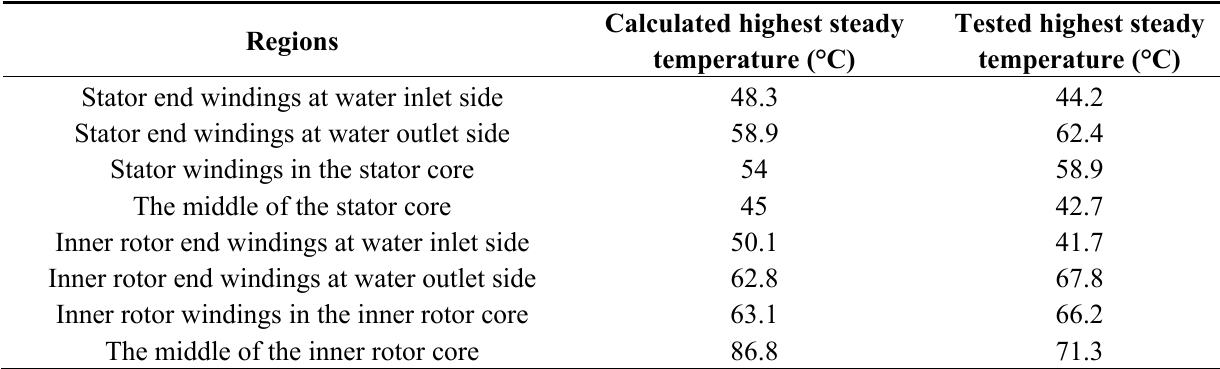
Table 14. Calculated and tested temperatures in the prototype when the SM and DRM run at rated torque and rated speed, and water cooling and force air are used in the